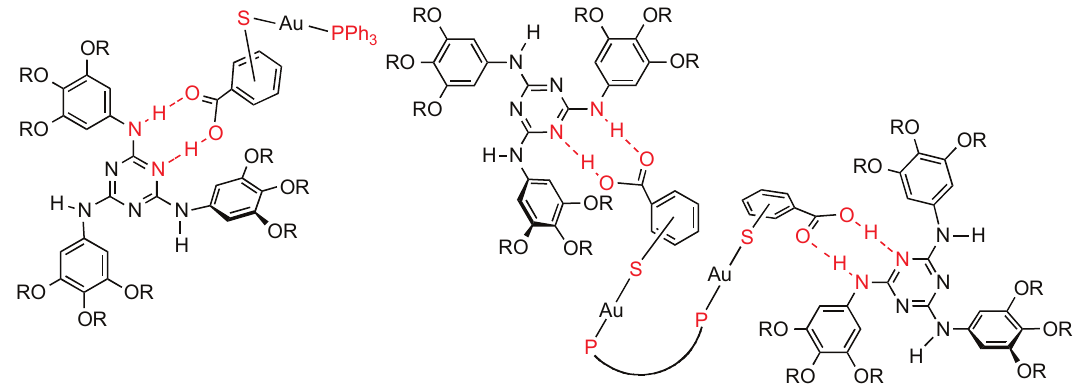
Figure 28. Supramolecular H-bond mesogens ( ortho , para substitution). R : C R -BINAP, S